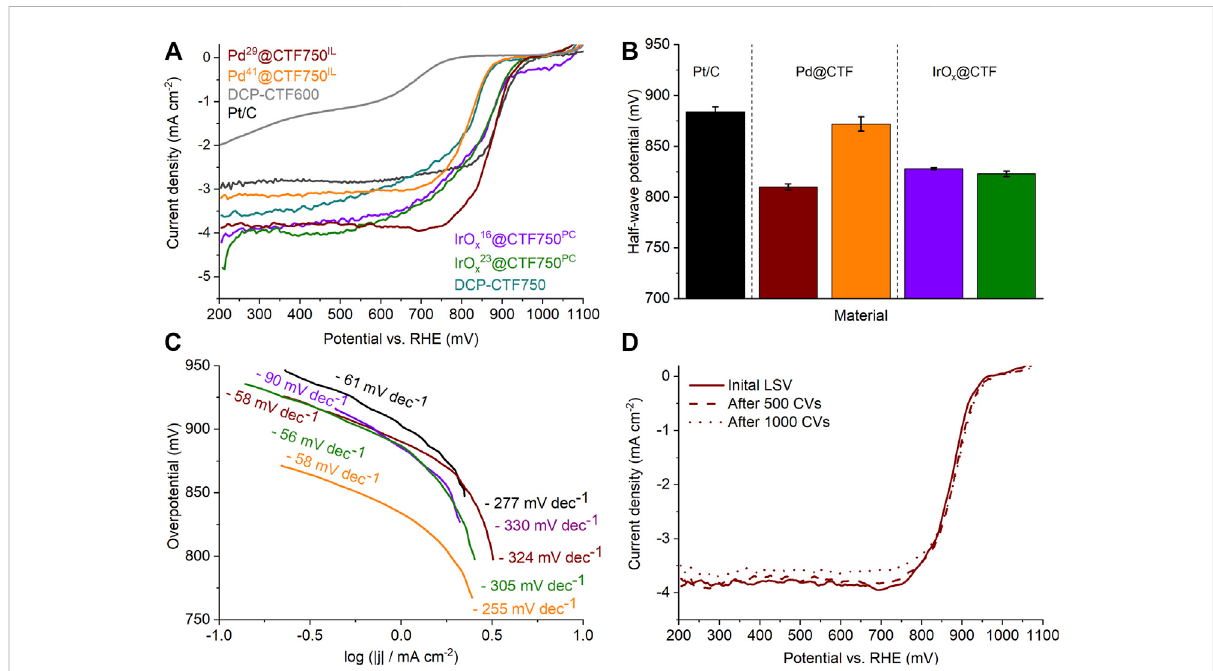
FIGURE 7 (A) ORR polarization curves, (B) half-wave potentials, and (C) Tafel plots of the Pd- and IrO X @CTF samples in 1.0 mol/L KOH. (D) Polarization curves of Pd 29 @CTF750 IL after CV stability test.